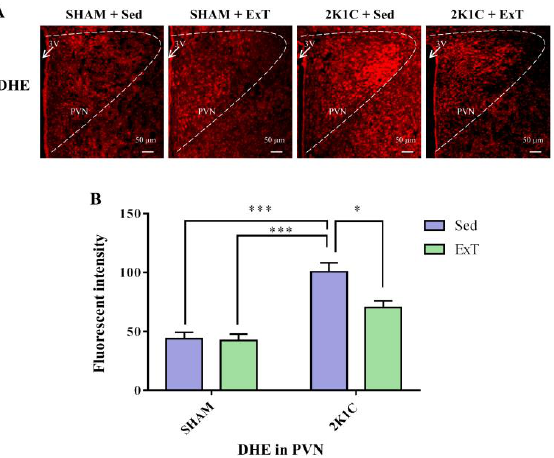
Figure 4. The effect of eight weeks of aerobic ExT treatment on ROS expression. ( A ) Representative images of DHE staining. ( B ) Densitometric analysis of DHE. 3V: third ventricle. * p < 0.05, *** p < 0.001, n = 4.